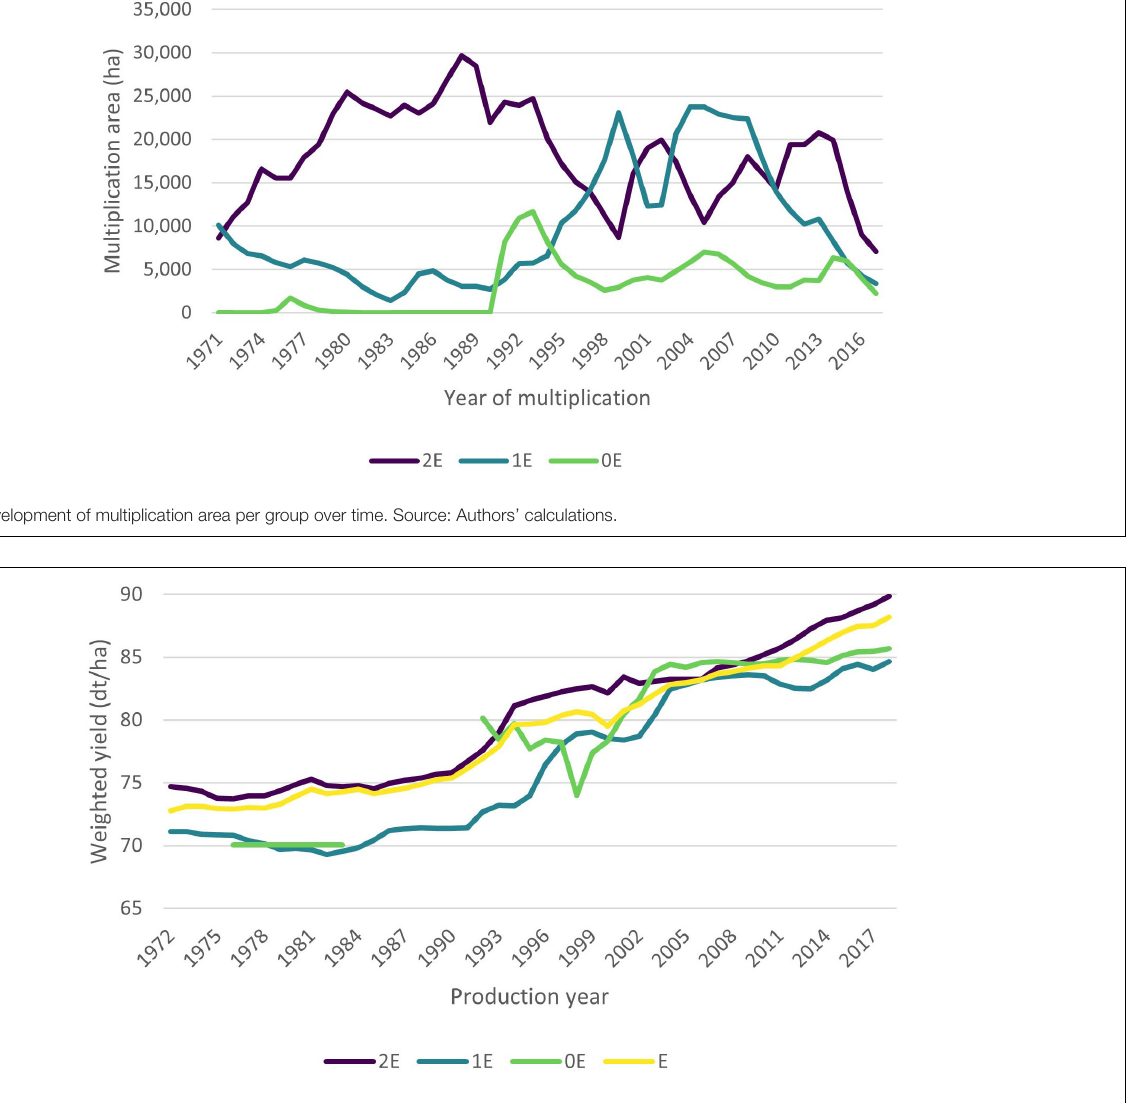
FIGURE 2 | Development of the weighted yield over time. For a better readability of the graph, the line of group 0E is not represented when there were no 0E-varieties that were planted according to our data set. Source: Authors’